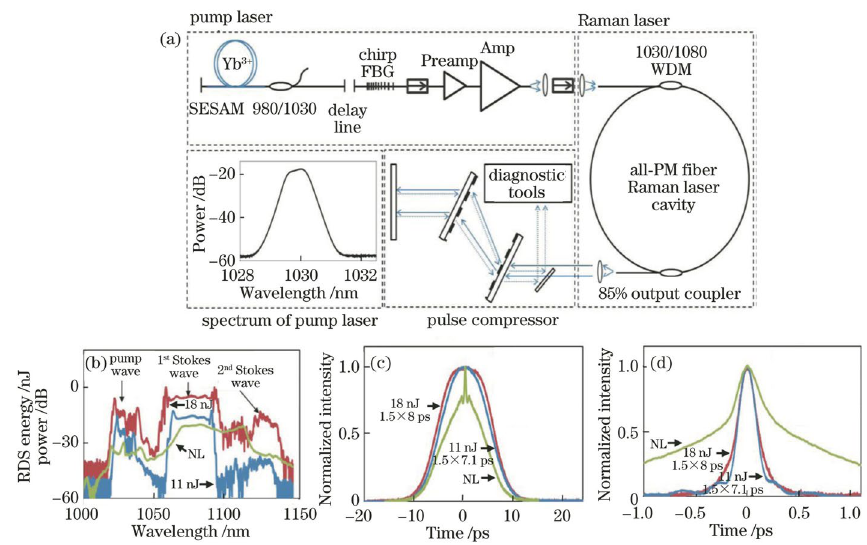
Fig. 10 ( a ) Scheme of the synchronously-pumped Raman fiber laser with a delay line. ( b ) Output spectrum. ( c ), ( d ) autocorrelation traces before and after compression